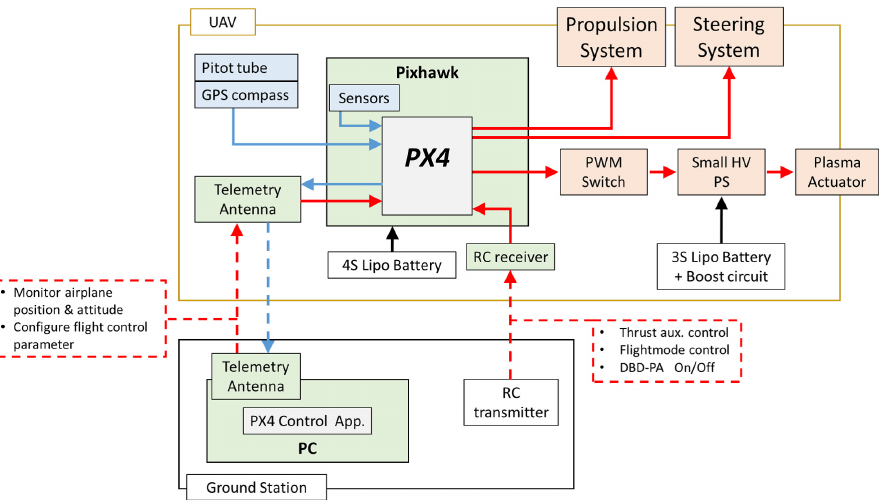
Figure 7. Overview of the UAV system, including the DBD-PA driving system and autonomous flight control